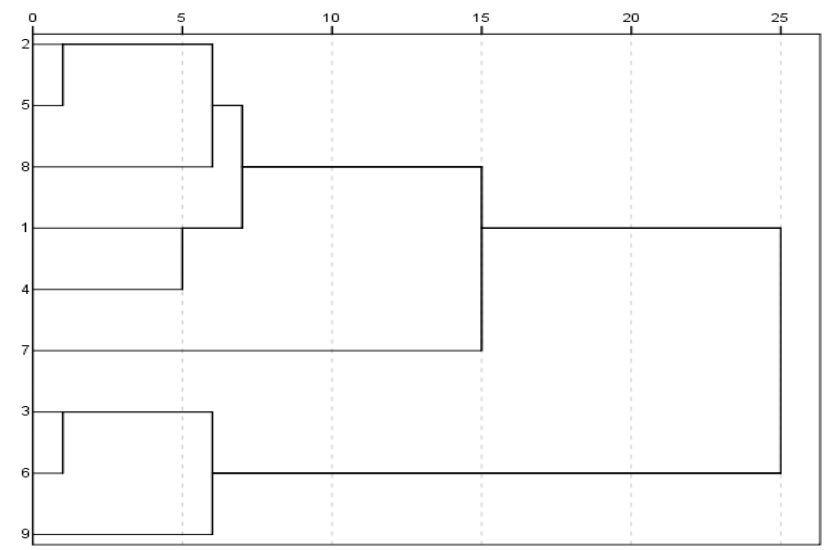
Figure 5. The dendrogram of cluster analysis of the nine GBE samples.